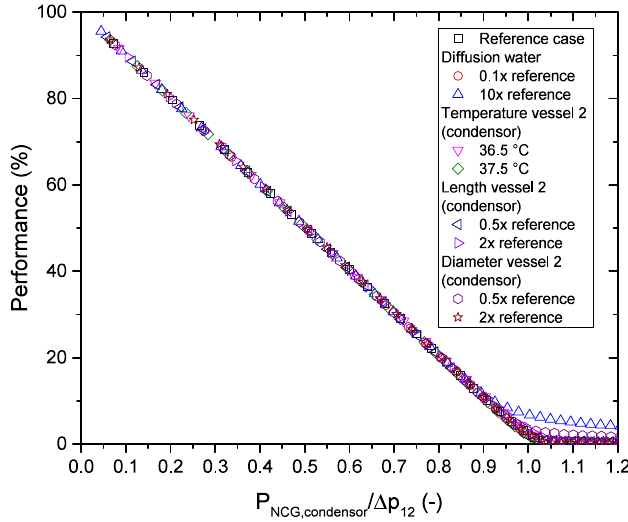
Figure 19. The performance (ratio of condensation flux rate with and without NCG in the vacuum system) plotted against the ratio of the pressure of the NCG at the condensation surface and the water vapor pressure difference between the condensor and evaporator. A combination of different geometries and workingconditions are shown, resulting in one